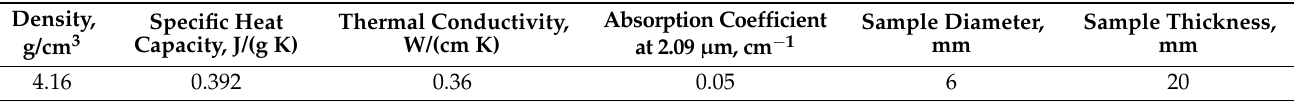
Table 3. The characteristics of ZGP crystals and the sample parameters used for estimation of the temperature rise in the center of the testing